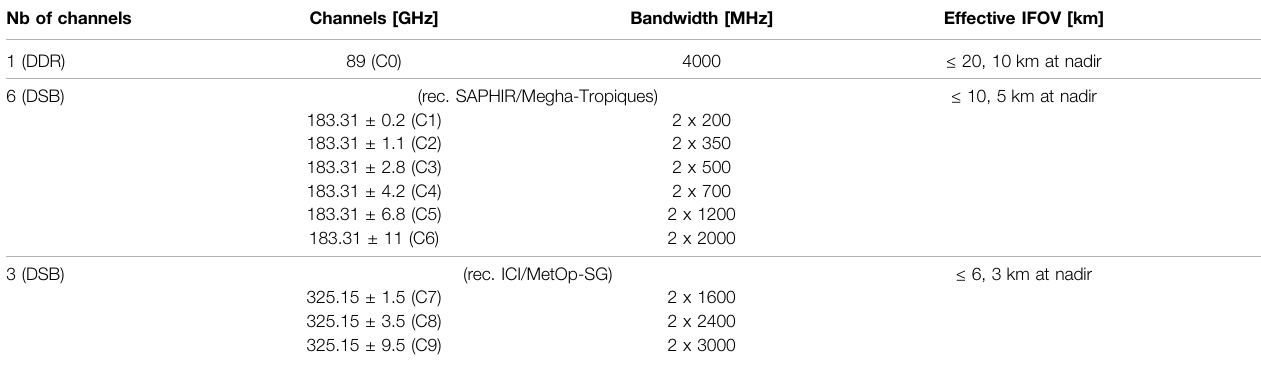
TABLE 1 | Main characteristics of the SAPHIR-NG radiometer. DDR: Direct Detection Radiometer. DSB: Double-Sided Band. Nb of